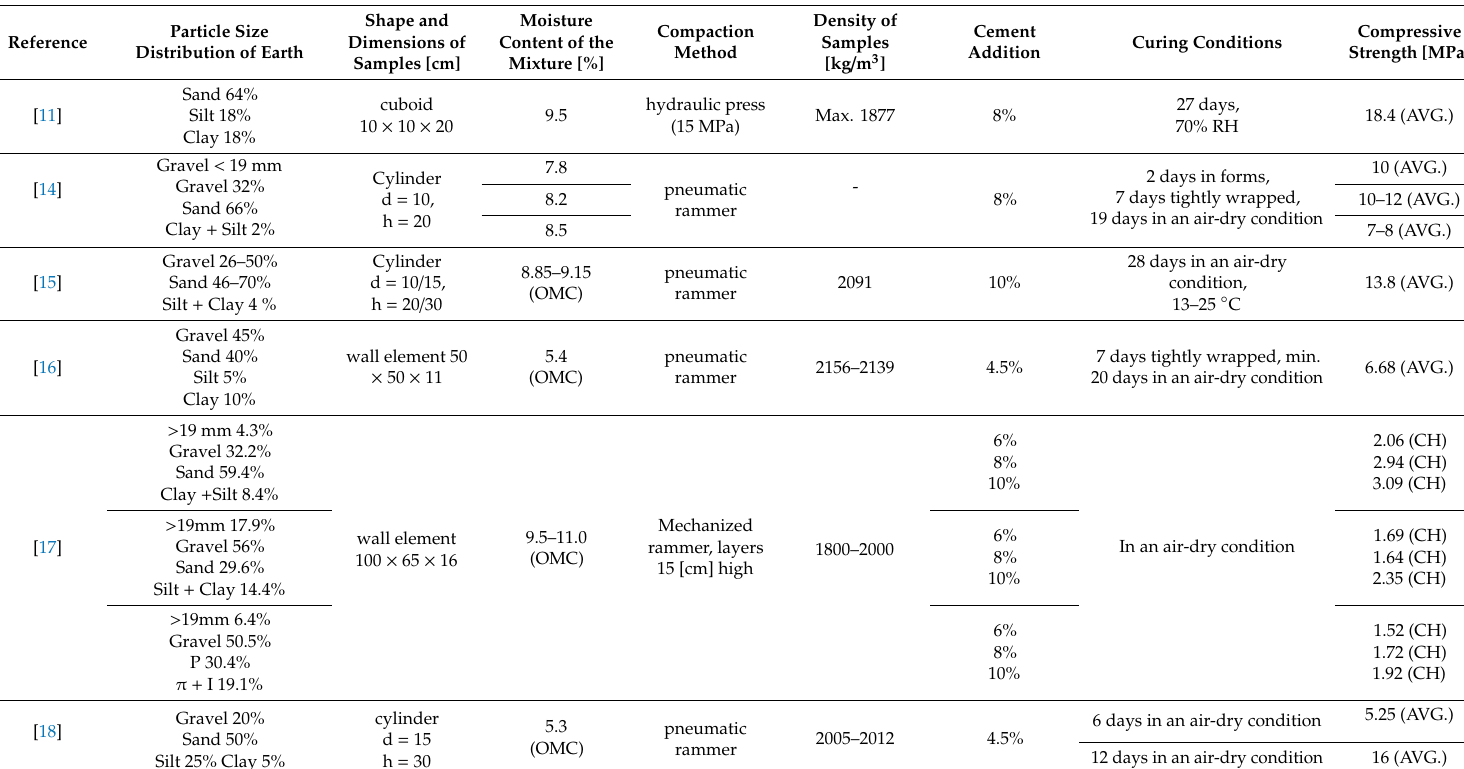
Table 1. Compressive strength results of CSRE from various references